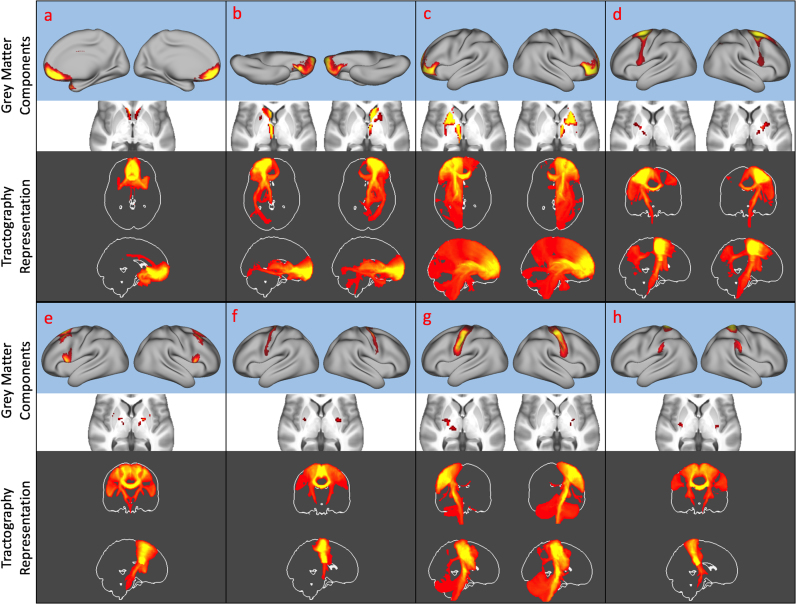
Basal ganglia-cortical loops decomposed using tractography and ICA. The top rows show the cortical (blue background) and subcortical (white background) representation of independent components, following an anterior to posterior gradient from a to h. The corresponding white matter tractography maps are shown as MIP (maximum intensity projection, orange with grey background). Some loops have lateralised components, in this case they are shown with their corresponding contralateral component (b,c,d,g) In all images, left is left.